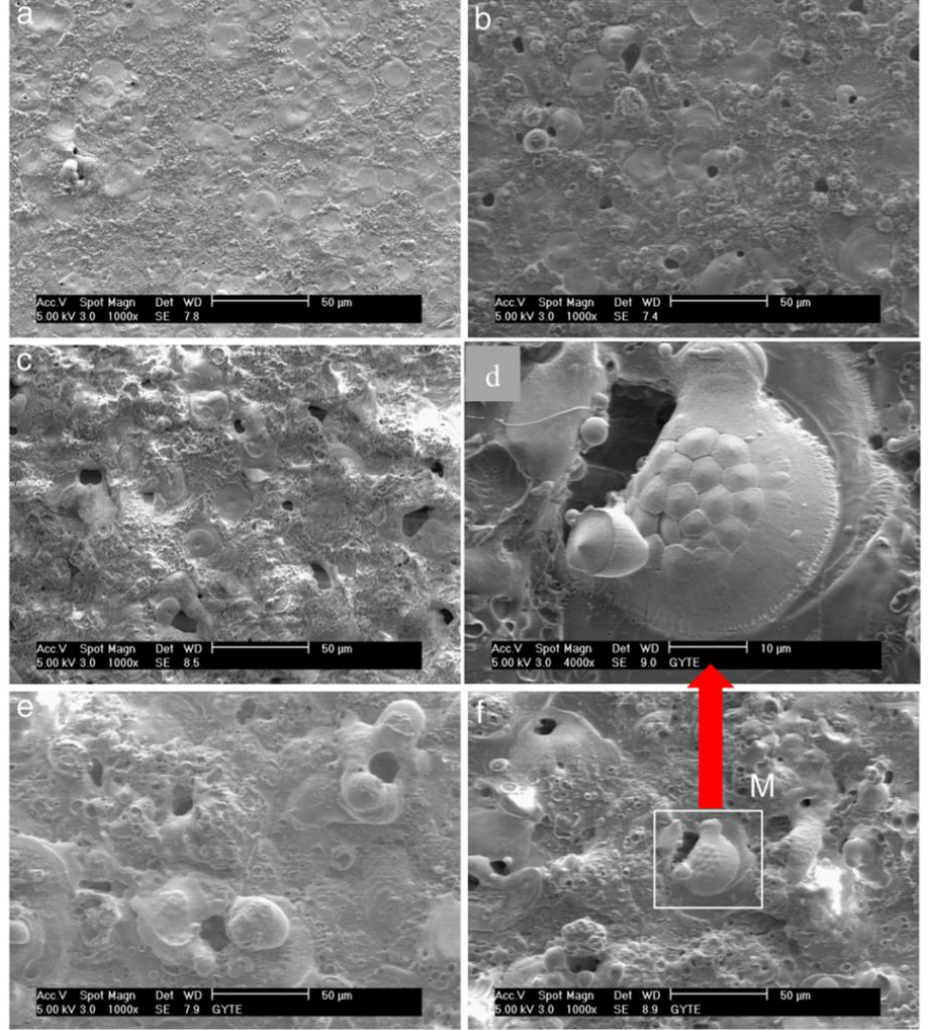
Figure 6. SEM images from the surface morphology of the PEO coating on pure Zr for the period of ( a ) 5, ( b ) 10, ( c ) 20, (d) 60, ( e ) 30, ( f ) 60 min. ( d ) High magnification of a typical SEM image of the cluster in equiaxed condition captured from the sub-figure ( f ) and marked as “M” for the processing time of 60 min [45] (reproduced with permission number: 5043520384143, Elsevier).